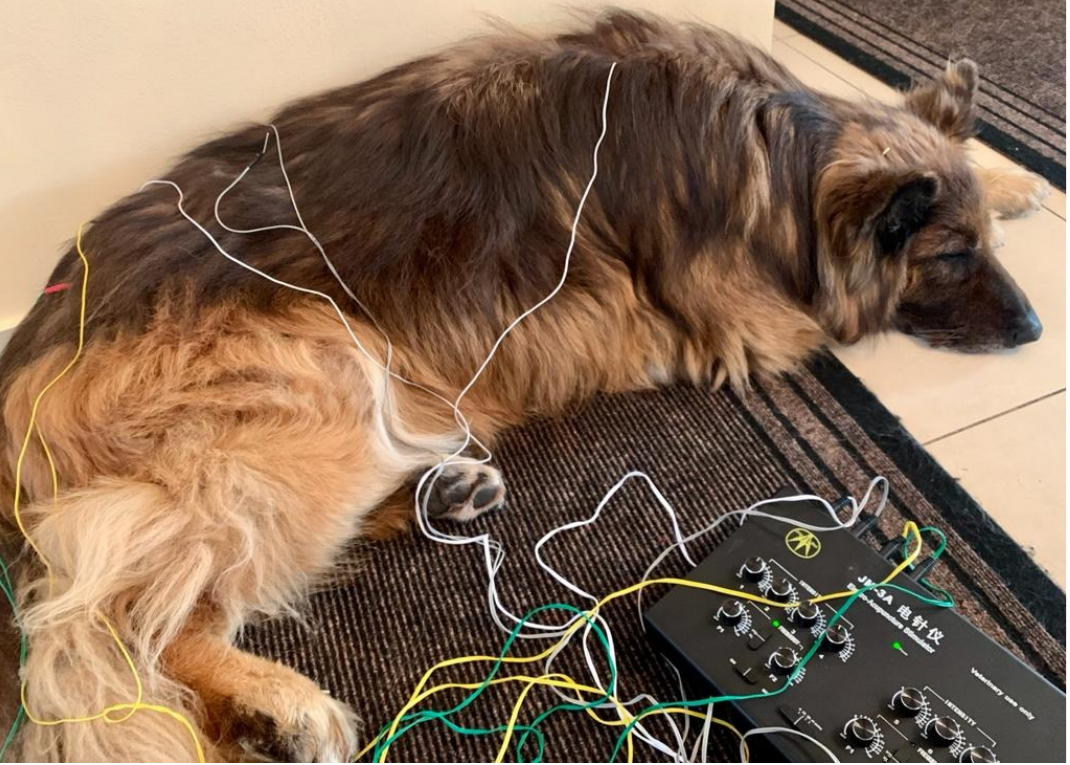
Figure 2. Rufus sleeping during the electroacupuncture treatment.